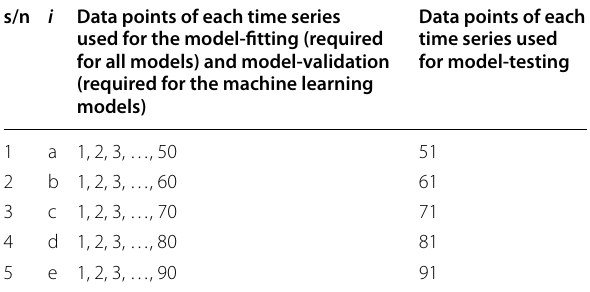
Table 10 Minimum, maximum and mean values of the MdoAE within the experiments using the PrecDat dataset